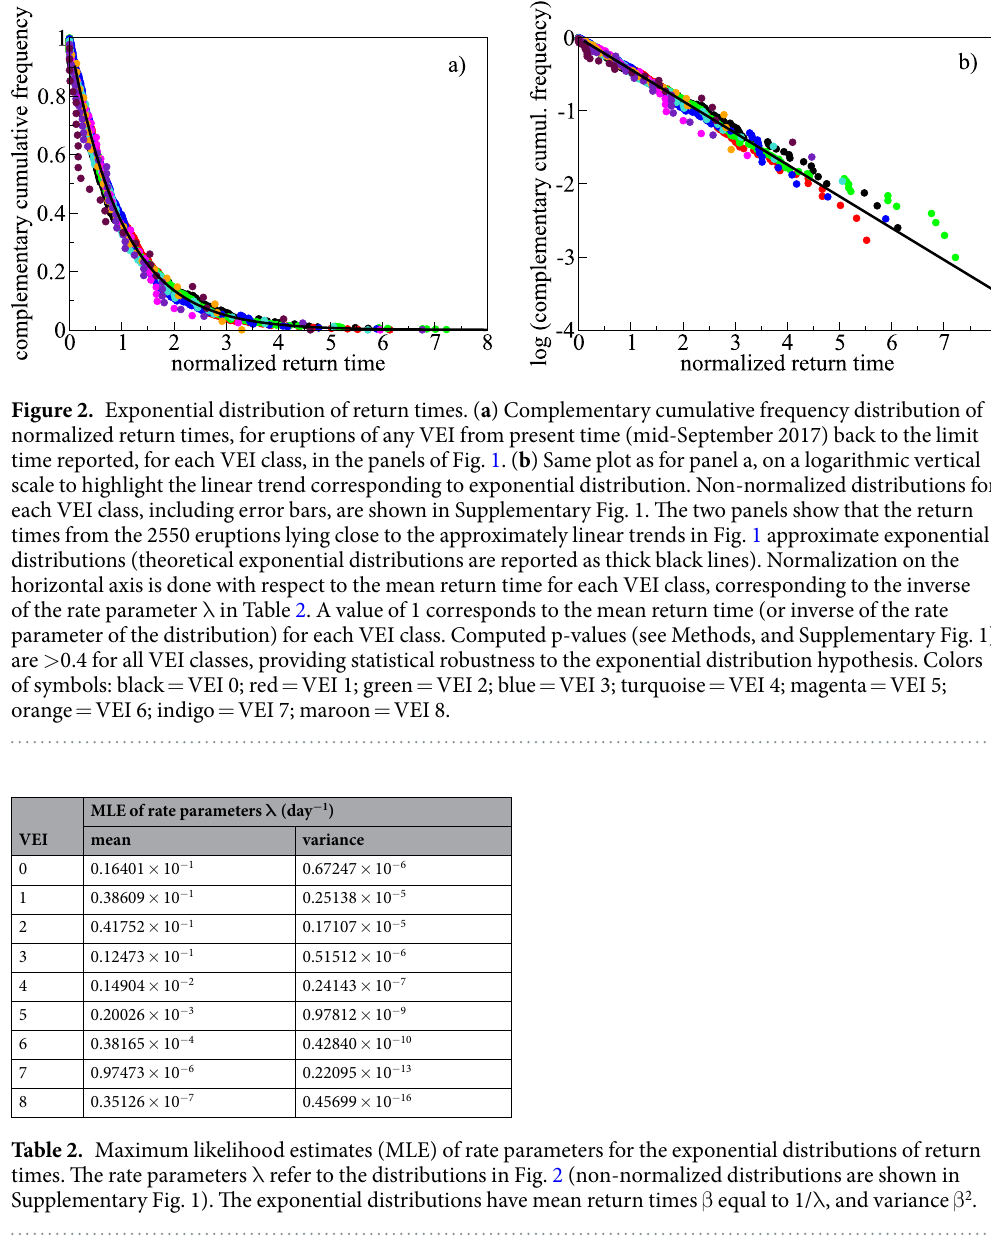
Figure 3, and the Supplementary Table 1, show the results of the MC simulation. With reference to the mean values in panel a, about 50% of eruptions on Earth are of VEI 1 or lower, and more than 99% are of VEI 4 or lower. Panel b shows that in a log-log plot of frequency vs. erupted volume, explosive eruptions with VEI 3 or higher describe a power law behavior with exponent equal to 1.95. Extensive analysis, testing, sensitivity analysis and com- putational details related to the power law distribution of relative eruption frequencies is reported in the Methods.